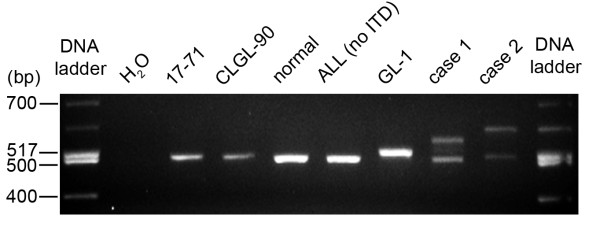
FLT3 PCR of genomic DNA. FLT3 PCR with intronic primers bracketing exons 14 and 15 was performed and the products separated on an agarose gel. Samples containing a FLT3 ITD (GL-1, Case 1, and Case 2) have a band with decreased mobility compared to the wild-type FLT3 gene (500 bp in size), which is seen in 17-71, CLGL-90, a dog without ALL, and a representative dog with ALL without the FLT3 ITD.